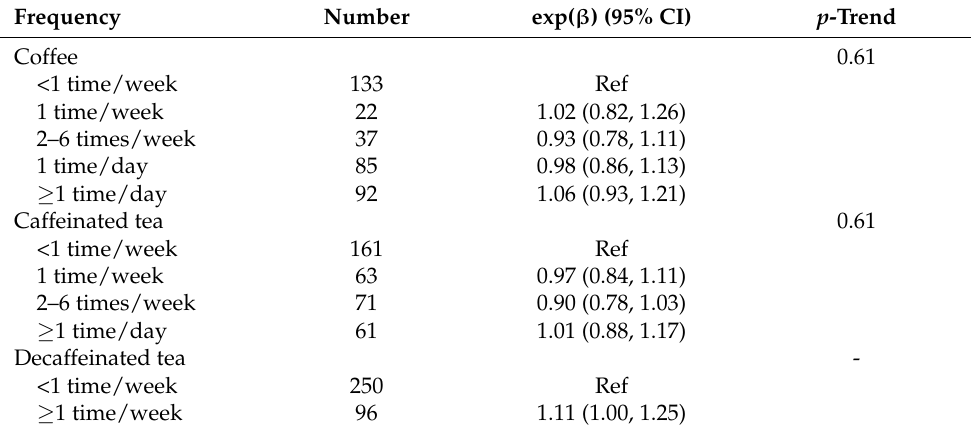
Table 2. Associations of coffee/tea intake with volumetric percent density in premenopausal women *.